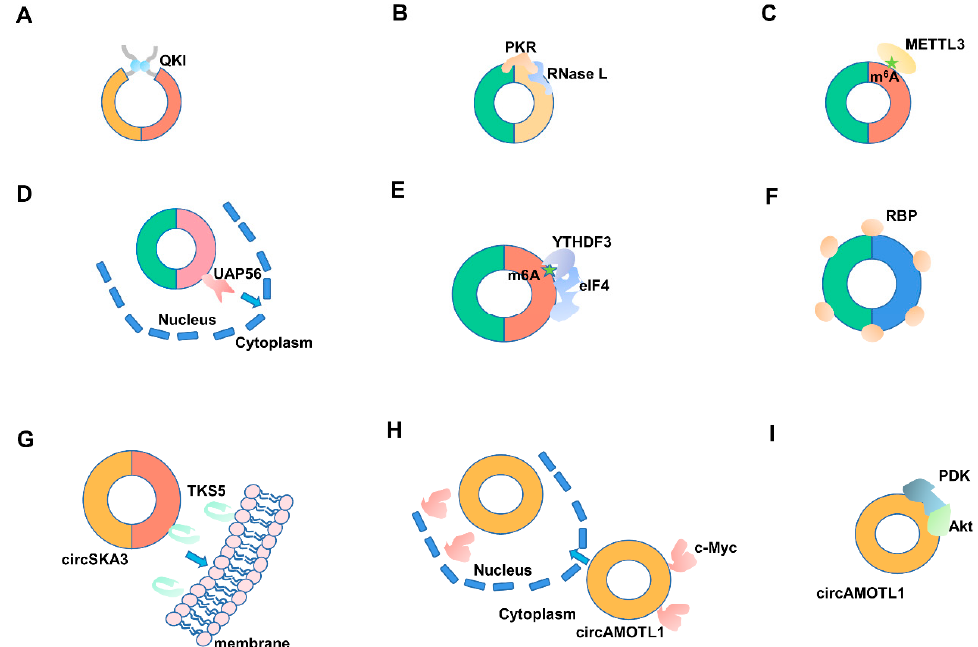
Figure 2. The interactions between circRNAs and RNA-binding proteins (RBPs). ( A , B ) RBPs regulate the synthesis and degradation of circRNA. ( C ) RBPs are involved in the modification and editing of circRNA. ( D ) RBPs participate in the transportation of circRNA. ( E ) RBPs control the translation of circRNA. ( F ) CircRNAs can serve as RBP supermolecular sponges. ( G ) CircRNAs participate in the transportation of RBPs. ( H ) CircRNAs serve as decoys for RBPs. ( I ) CircRNAs function as scaffolds for RBPs. m 6 A: N 6 -methyladenosine.